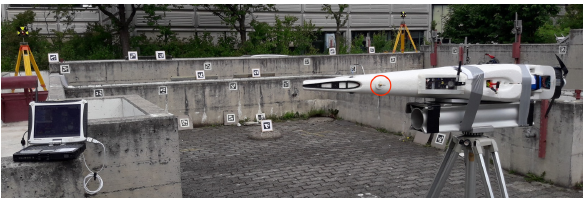
Figure 3. Lever-arm calibration camera to GNSS antenna, phase-center of which is represented by a tip of pin (red-circle).